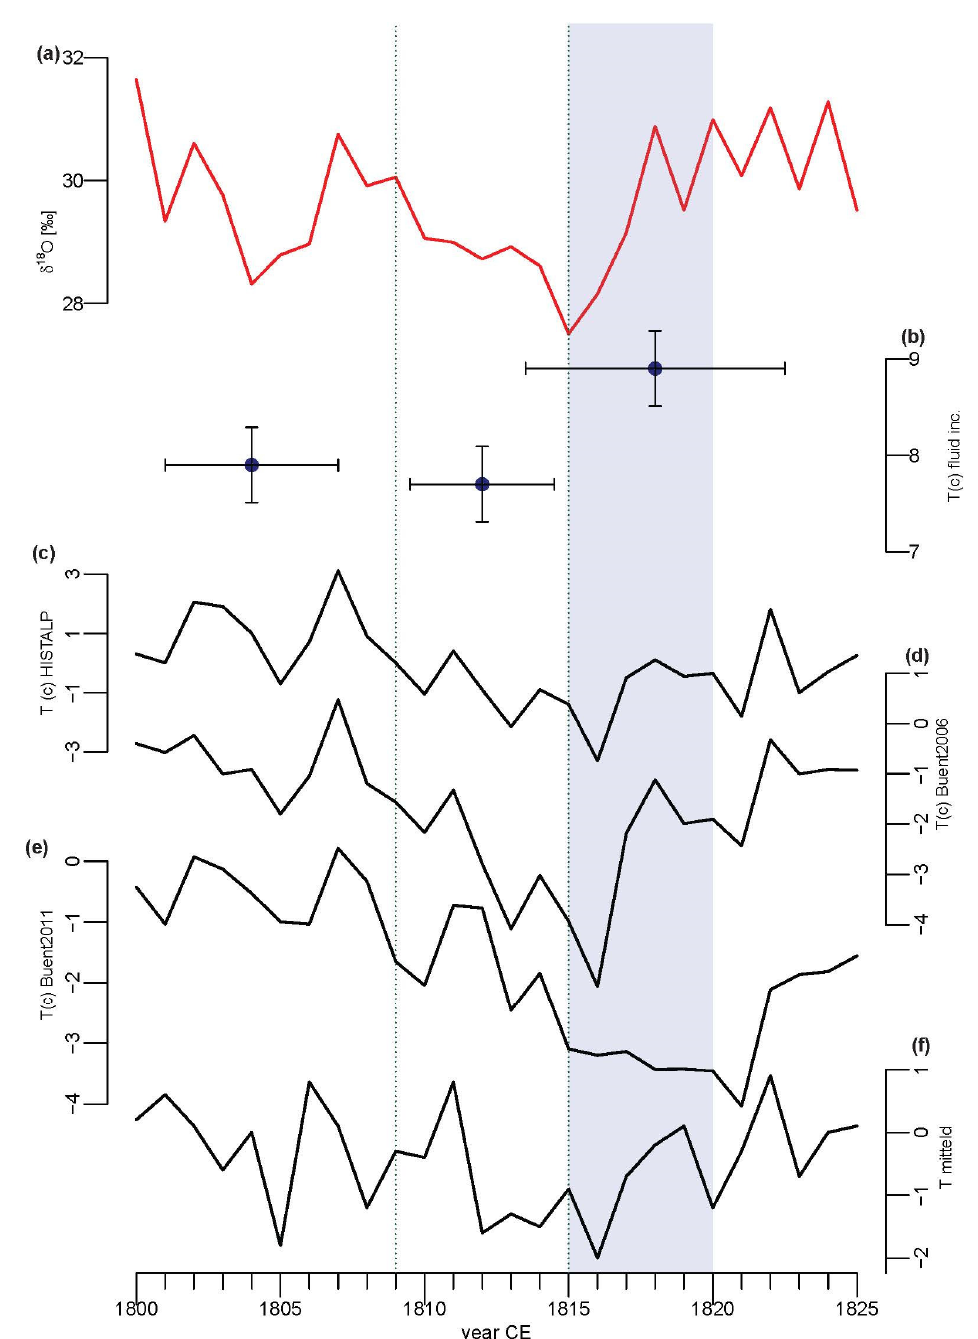
Figure 3. Comparison between the trends of tree-ring oxygen isotopes and those of other climate proxies in the period of the Tambora eruption: ( a ) Average series of the δ 18 O values of the two trees with annual resolution. ( b ) Temperature from the speleothem fluid inclusions from Milandre Cave.